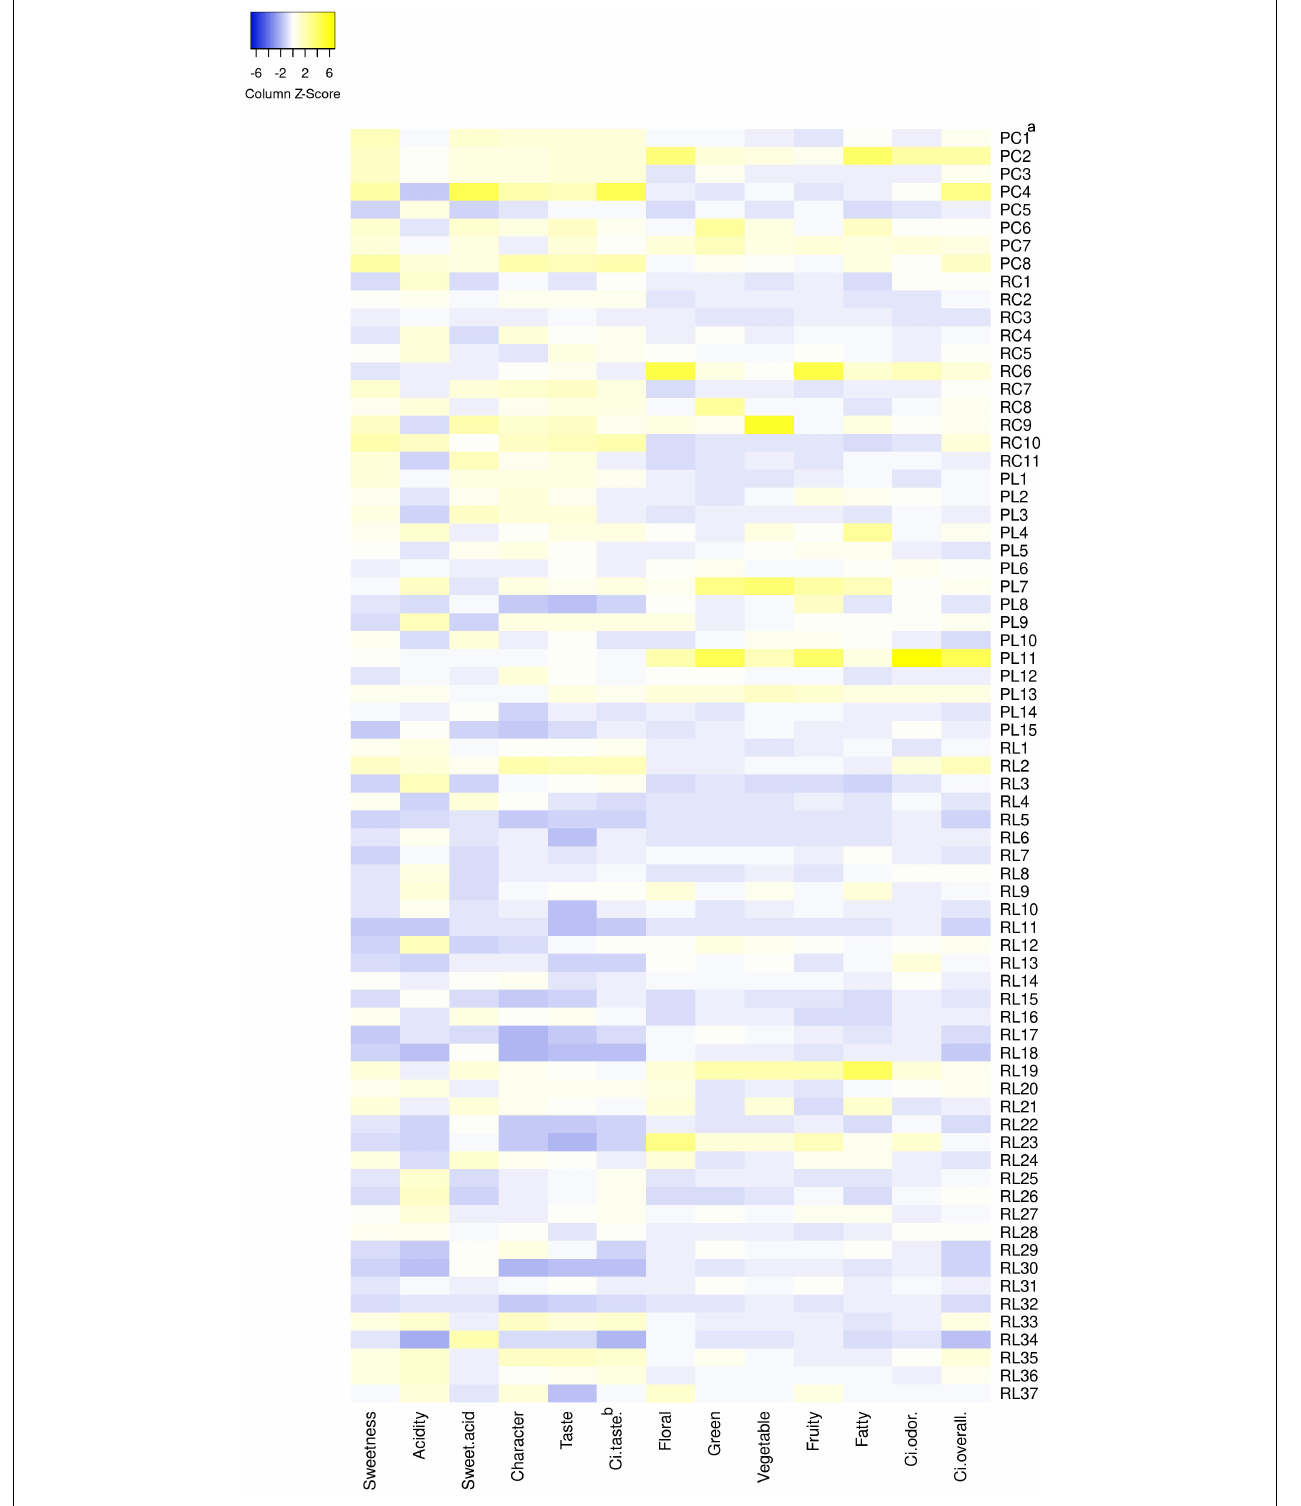
FIGURE 2 | Heat map of the sensory evaluations of taste and odor characteristics of 71 tomato accessions. a PC, PL, RC, and RL indicate pink cherry tomato, pink large-fruited tomato, red cherry tomato, and red large-fruited tomato, respectively. b C i values represent the scores of the DTOPSIS analysis.